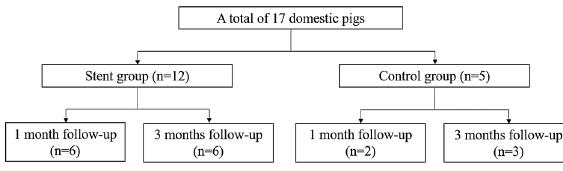
Figure 2. Flow diagram of animal allocation.